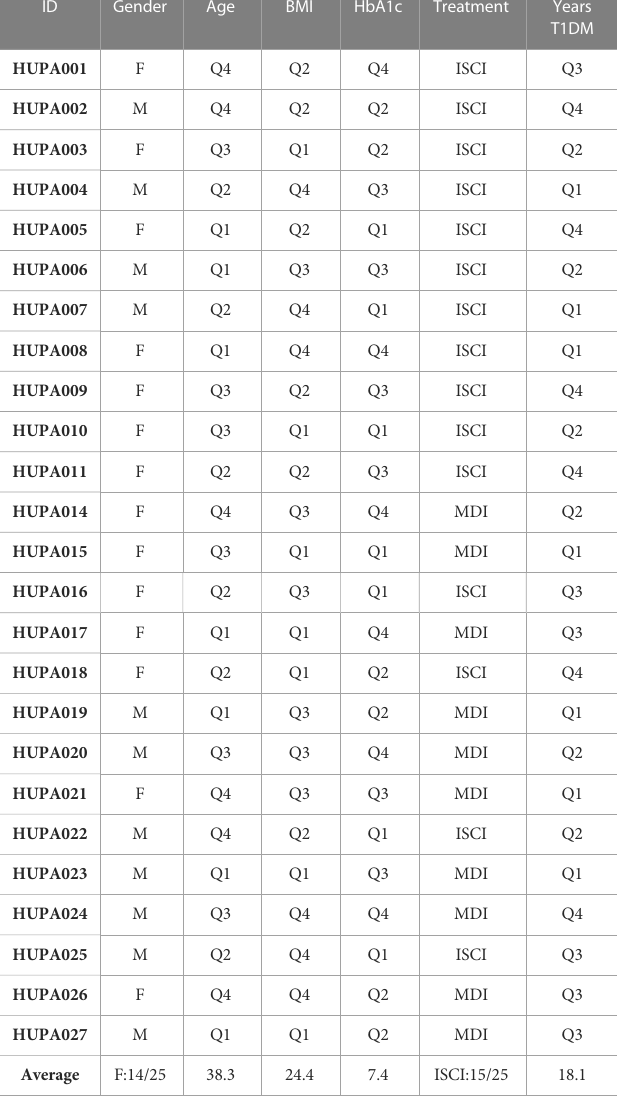
TABLE 1 Characteristics of the participants: ID, Gender (M, Male; F, Female; Sex assigned at birth coincides with gender identity for all participants), Age, BMI, HbA1c, Treatment (MDI, Multiples doses of insulin; ISCI, Infusion Subcutaneal continuous of insulin); Years of evolution of